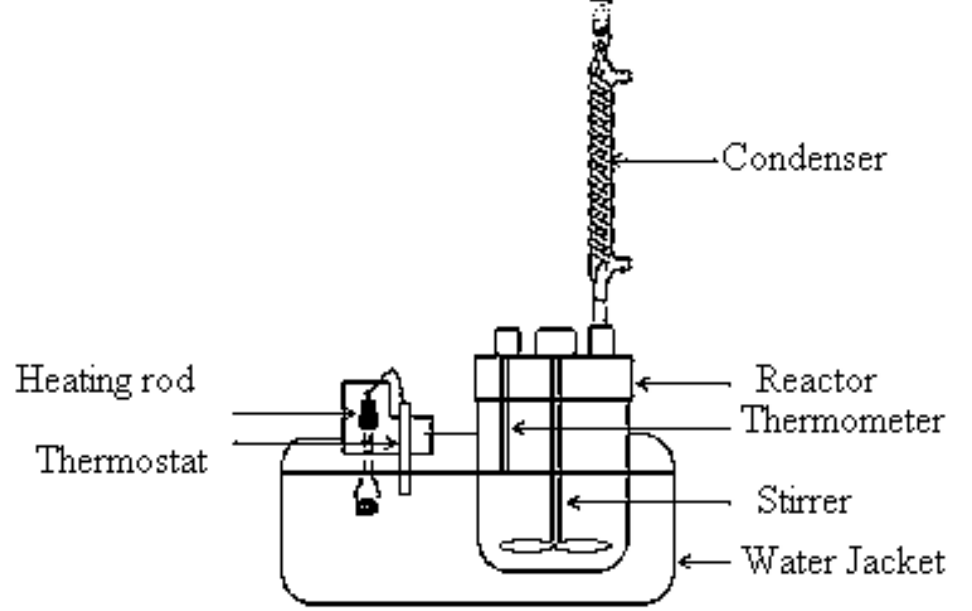
Figure 1. Representation of the reactor ’ s schematics .